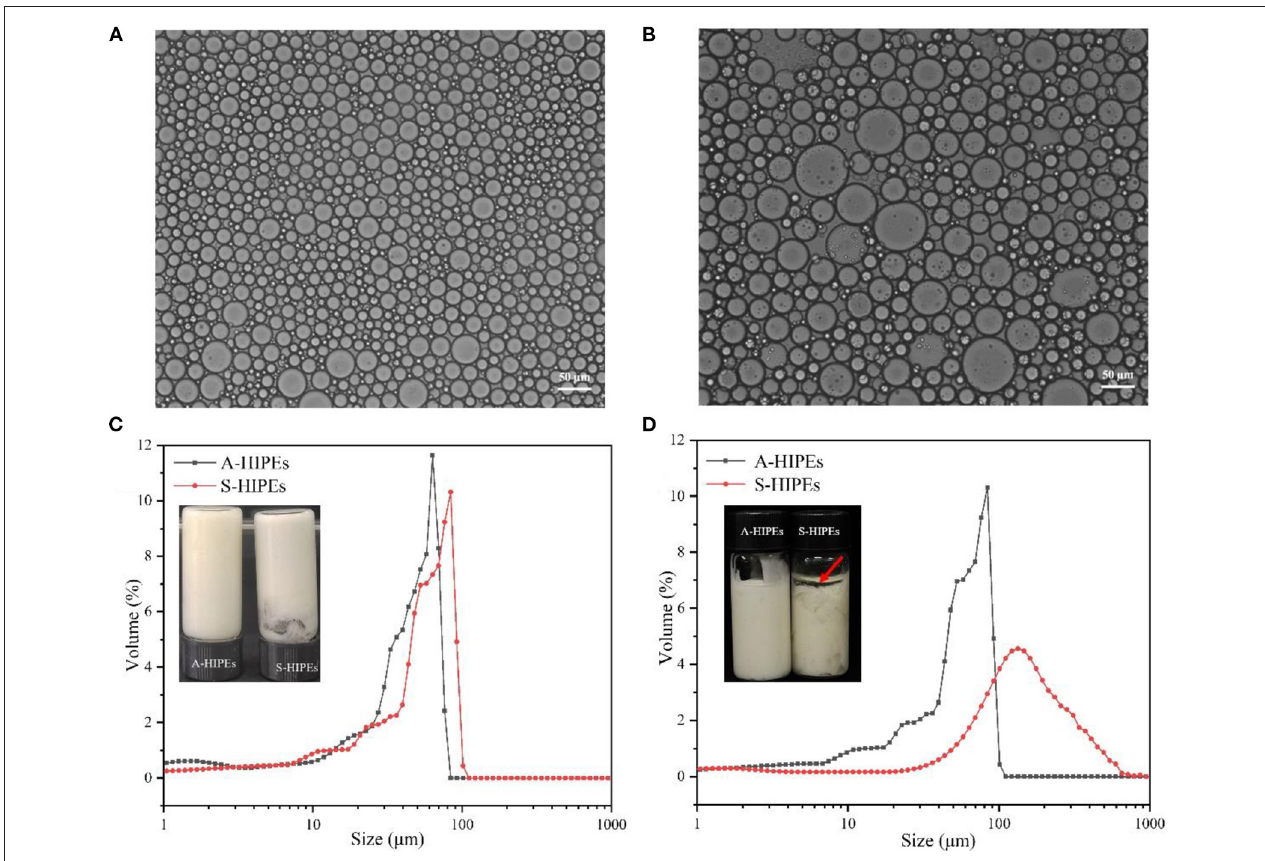
FIGURE 4 | Optical micrographs of A-HIPEs (A) and S-HIPEs (B) . The bar lengths of optical micrographs represented 50 µ m. The appearance and size distribution of the HIPEs stabilized by BCNs/SPI colloidal particles using different self-assembly methods ( C : new preparation; D : 1 month later).